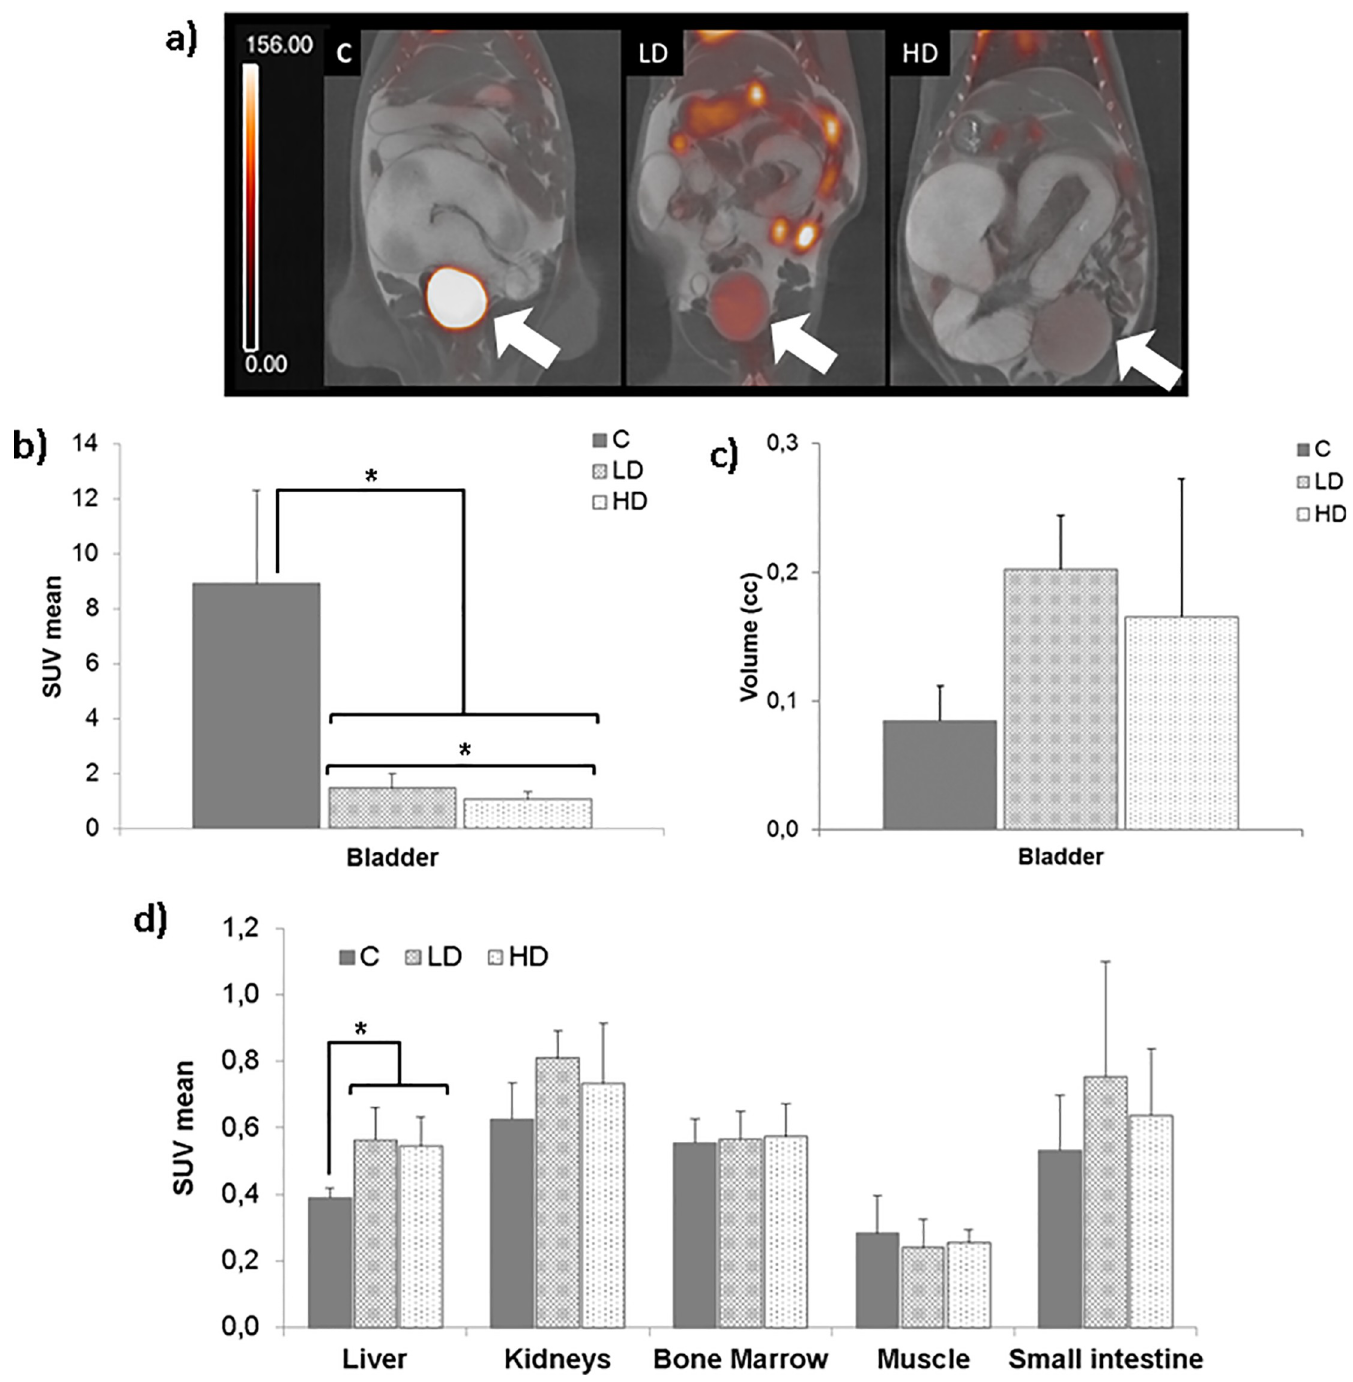
Fig 2. PET-CT images. (A) Coronal PET (red scale, cps x 10 − 3 ) and CT (gray scale) images of a control animal (C), low dose (LD, 3.5 mg/kg), and high dose (HD, 7 mg/ kg). The bladder signal (arrow) is lower in treated animals than in controls. (B) Both furosemide doses led to a reduction in bladder SUVmean compared with the control group. (C) Bladder volume of the treated animals is slightly higher than the controls. (D) Non-significant differences were observed in kidney, bone marrow, small intestine and muscle uptake, although an increase in SUVmean was observed in the liver. � p < 0.05.